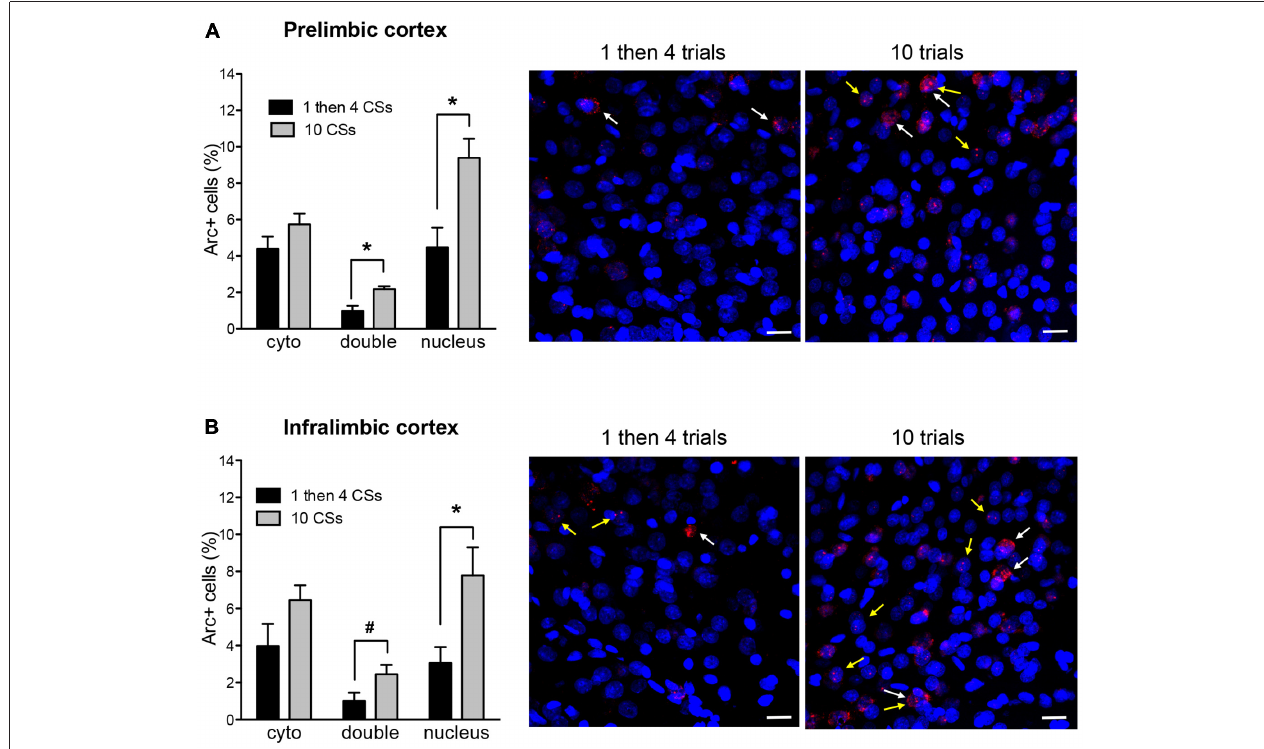
FIGURE 3 | The bar graphs show percentage of DAPI+ cells expressing Arc mRNA in the cytoplasm (cyto), nucleus, or both (double) in the prelimbic cortex (PL) (A) and infralimbic cortex (IL) (B). The photomicrographs are maximum intensity projections of representative z -stacks from the sampled regions in the medial prefrontal cortex (mPFC). DAPI+ cells are shown in blue and Arc mRNA are shown in red. The yellow arrows point to Arc foci in the nuclei and the white arrows point to the Arc in the perinuclear areas (cytoplasm). Scale bar = 20 µ m. ∗ p < 0.05, # p =